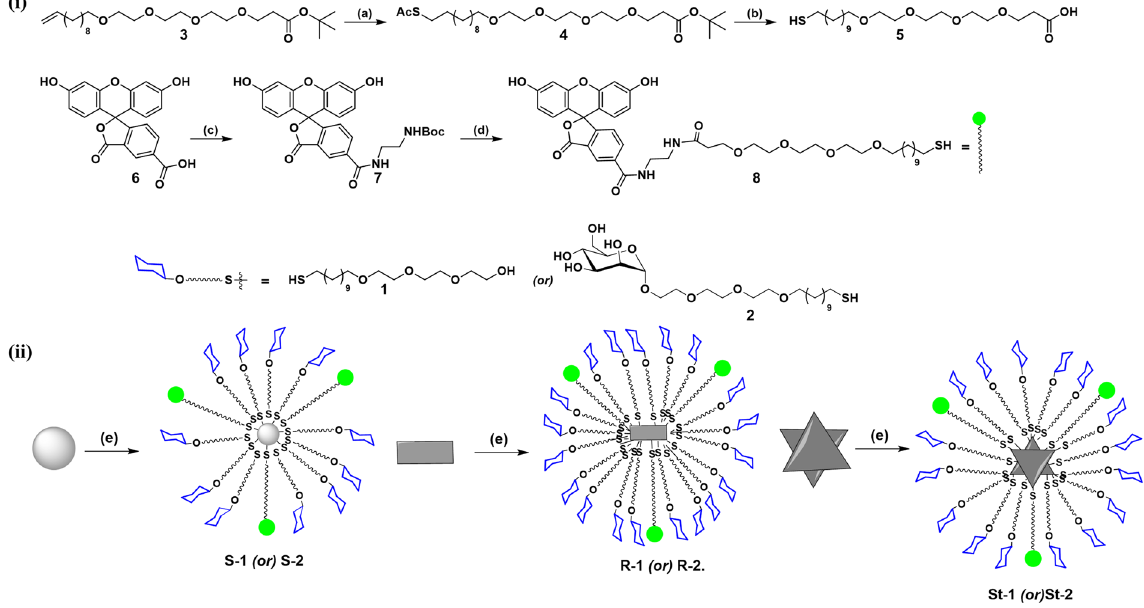
Figure 1. ( i ) Synthesis of Fluorescein modified linker: (a) AIBN/thioacetic acid/1,4-Dioxane; (b) ( i ) NaOMe, MeOH, 2 h, ( ii ) TFA: DCM (1:1), 2 h; 90%; (c) tert -butyl (2-aminoethyl)carbamate, EDCI, HOBt, Pyridine, 12 h, 60%; (d) TFA: DCM (2:8), 95%. ( ii ) Synthesis of Fluorescence conjugated G-AuNPs: (e) mixing of respective sugar ( 1 or 2 ) followed by 8 in water and methanol mixture (1:1) at RT for 12